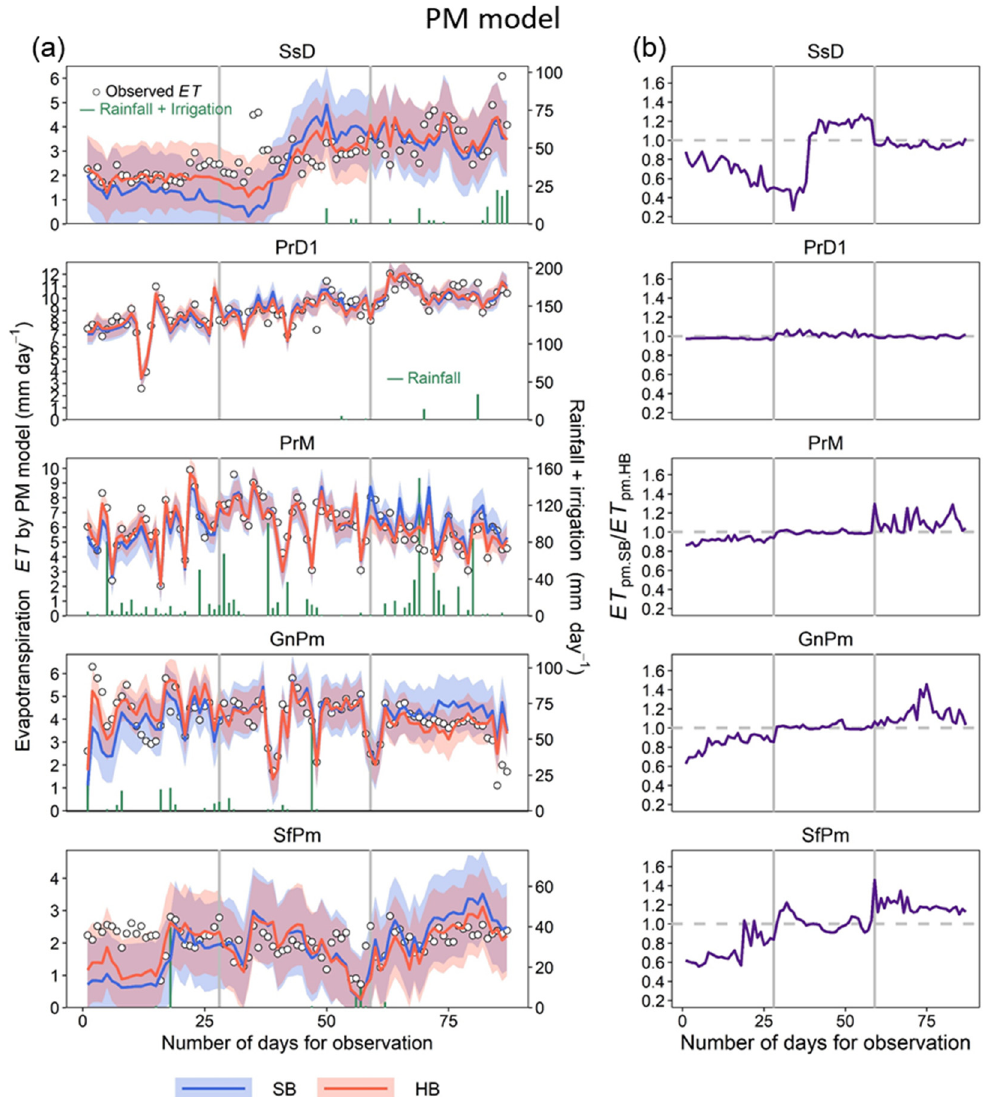
Figure 6. ( a ) Observed and estimated evapotranspiration ( ET ) using the Penman–Monteith (PM) model with parameters calibrated using the simple Bayesian (SB) and hierarchical Bayesian (HB) approaches. Lines and bands correspond to the posterior means and confidence intervals at the 95% probability, respectively, in all five observation conditions. Vertical bars indicate the rainfall + irrigation amount for the SsD and rainfall only for the others. ( b ) Variations in the values of ET pm.SB and ET pm.HB calculated from ET estimates by the PM model using SB and HB. The three calibration periods for HB are separated by vertical lines.